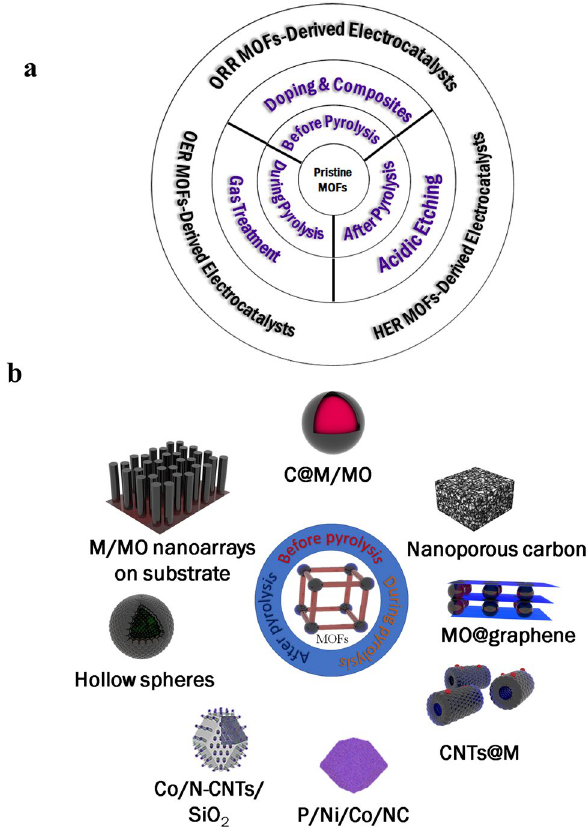
Fig. 3 a A schematic summary for general synthesis protocols for advanced electrocatalysts derived from MOFs. b Descriptive scheme of tailoring MOFs and MOF-based